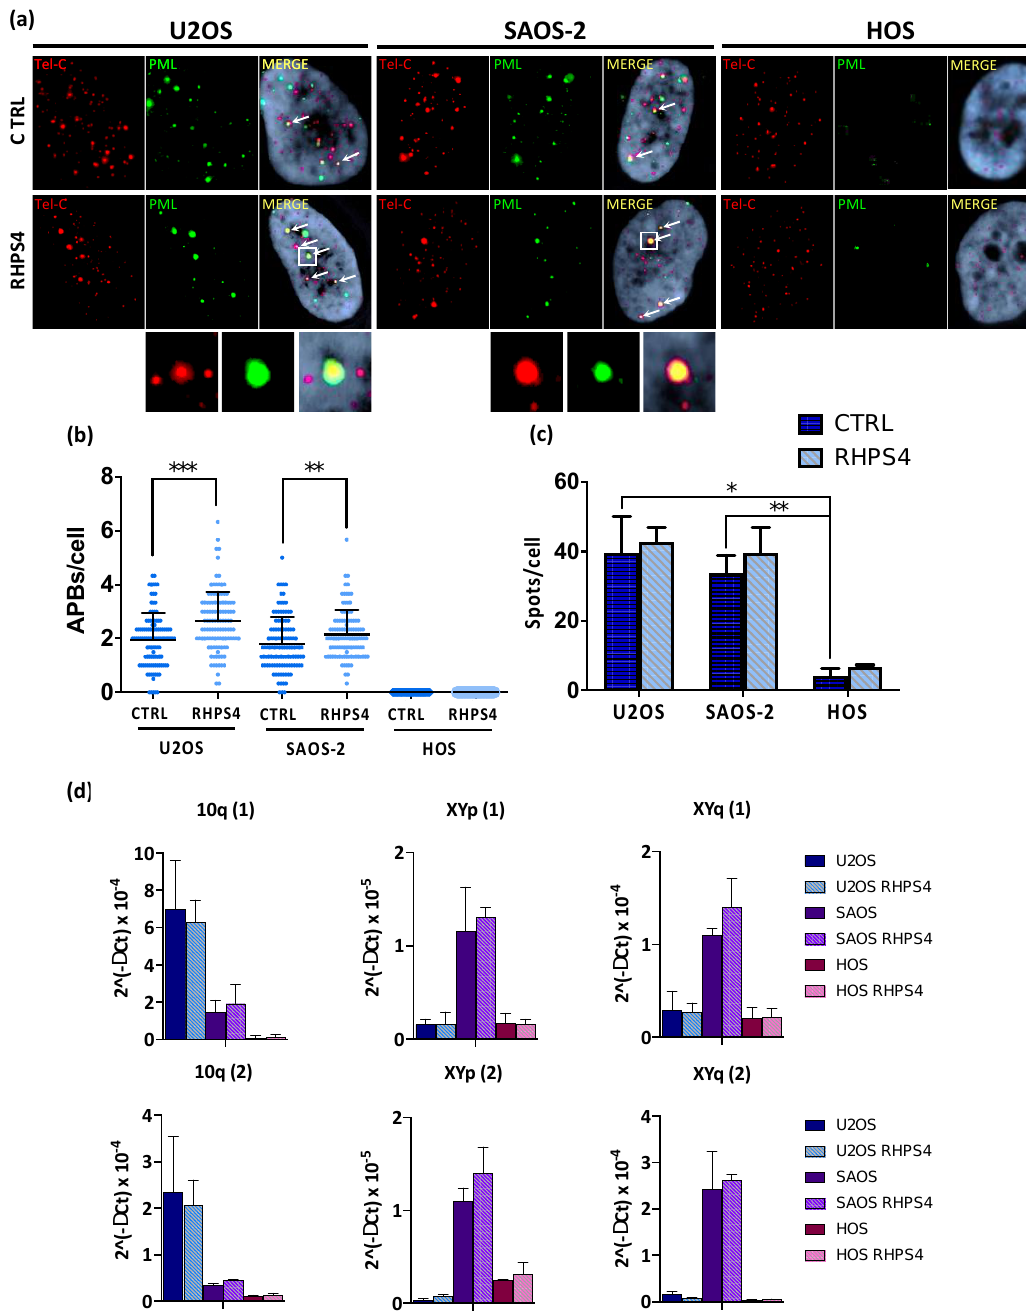
Figure 4. ( a ) Representative images of ALT-associated PML bodies (APBs) in osteosarcoma cell lines after 120 h treatment with RHPS4 obtained by immune-FISH technique. For each line and condition, single channels (PML signals in green and telomeric signals in red) and merged images are illustrated. Arrows indicate PML and telomeres colocalization. ( b ) Dotplot showing colocalizations per cell between telomeres and PML protein. Black lines denote the means and errors bars denote standard deviations. ( c ) Histogram of TERRA frequency in osteosarcoma cell lines obtained by RNA–FISH technique. Data were obtained counting number of spots for each nucleus. Errors bars denote standard deviations. ( d ) qPCR analysis of the expression of TERRA transcribed at different subtelomeres. Errors bars denote standard deviations. * p < 0.05, ** p < 0.01, *** p < 0.001 (Student’s t - test).